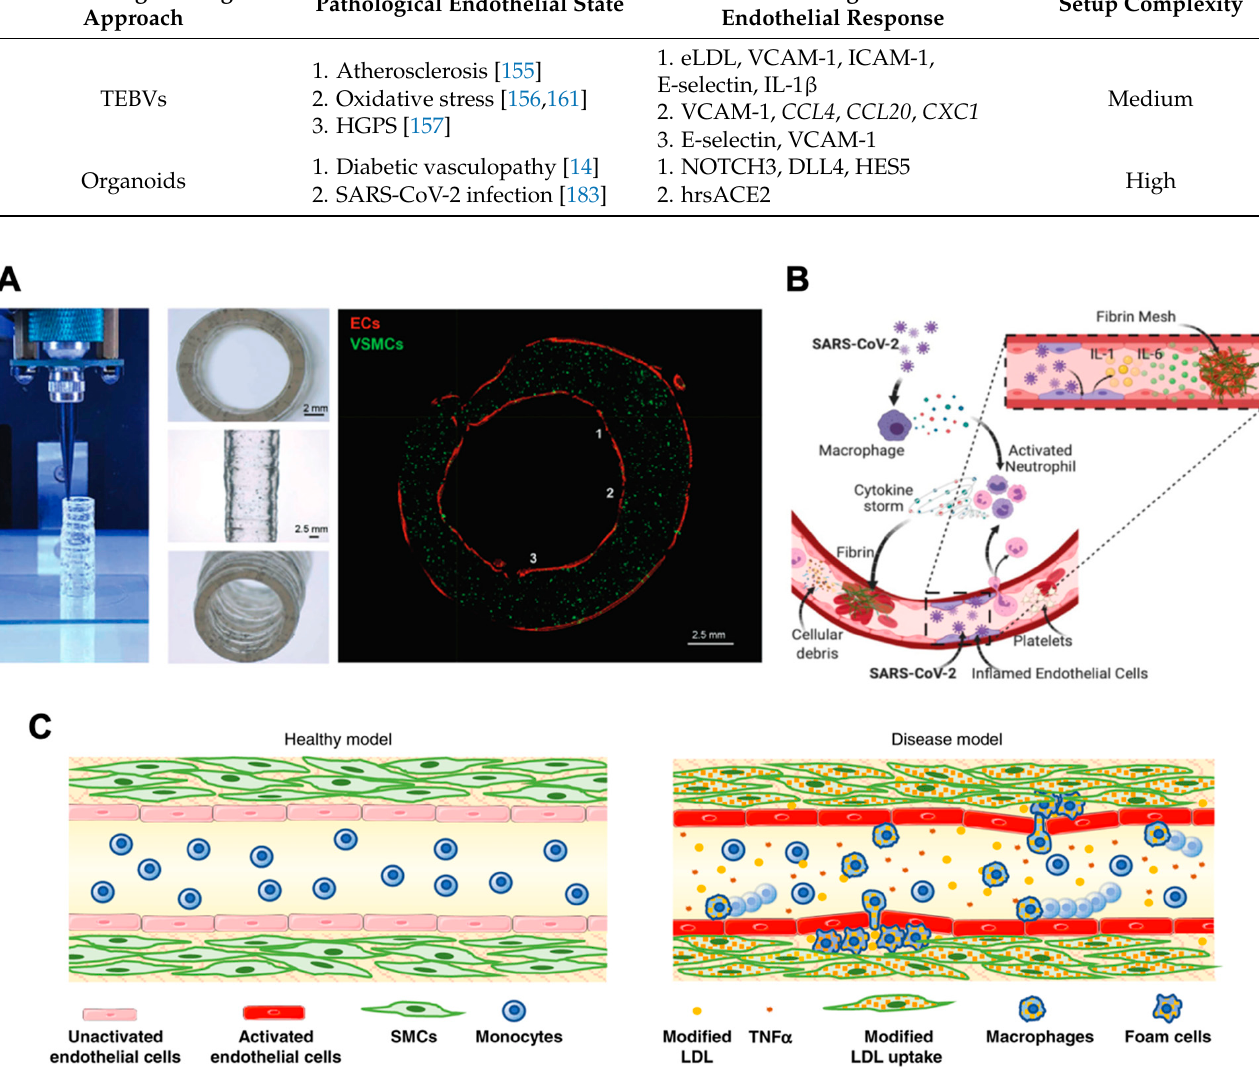
Figure 2. Advanced tissue-engineered approaches to modeling endothelial disease. ( A ). ECs and VSMCs co-cultured in a 3D bioprinted vascular model. Reprinted/adapted with permission from [113]. 2022, John Wiley and Sons. ( B ). Infection with SARS-CoV-2 induces the release of cytokines, including IL-1 and IL-6, that promote platelet activation and initiation of the coagulation cascade. The schematic was adapted with from [145]. ( C ). TEBV model for the onset of atherosclerosis. Treat- ment with eLDL and TNF- α results in activation of the vascular endothelium and leads to macro- phage infiltration and foam cell accumulation on the vessel walls. The schematic was adapted from